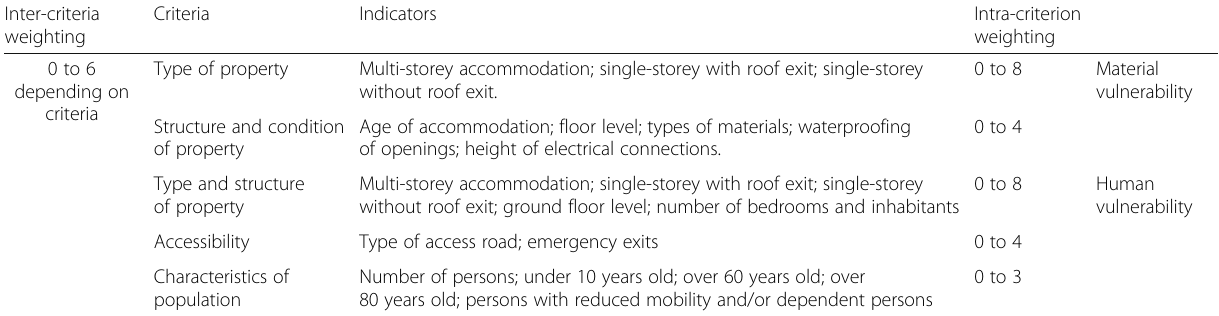
Table 2 Extract from list of vulnerability criteria and indicators applied to Leucate (the sample of individuals surveyed) Inter-criteria